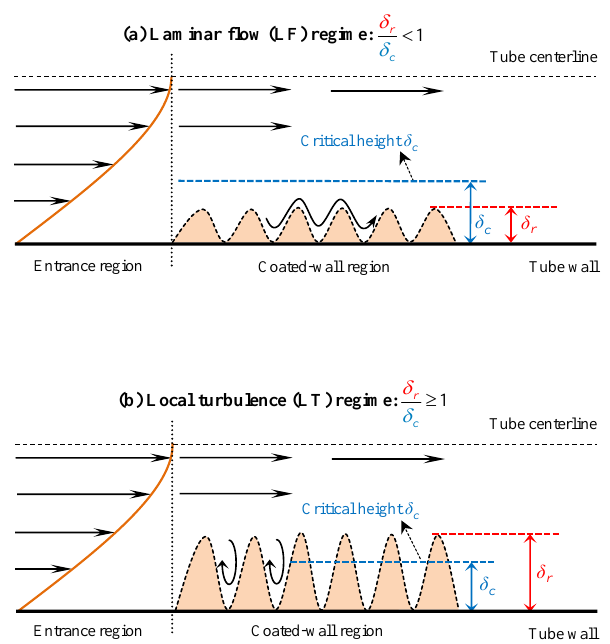
Figure 3. Schematic of the critical height δ c and its related flow conditions in a flow tube with rough coatings. Upstream of the coated-wall region, the entrance region is designed to warrant well- developed laminar flow conditions. Two cases of tube coatings re- flect different impacts of a roughness element with varying height δ r on flow